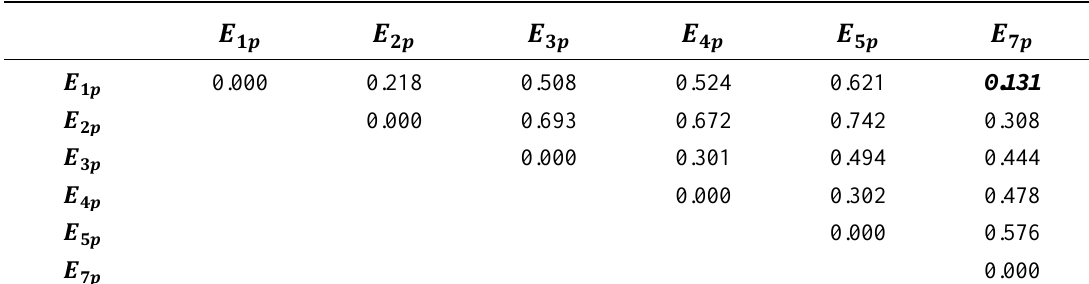
Table 4. SA values of endmember set after the second processing step. The values shown in bold italics are those less than the threshold